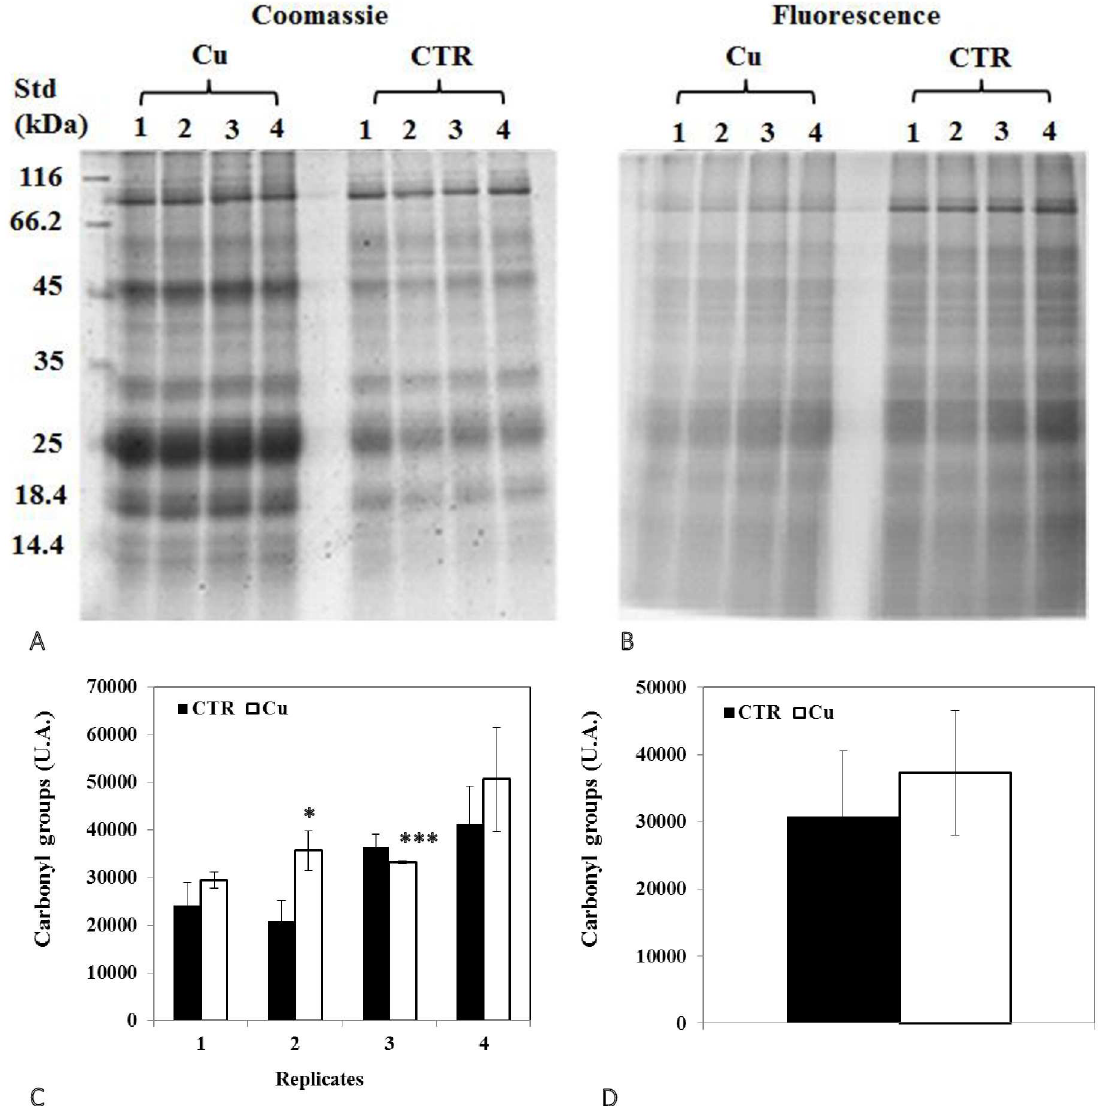
Fig 8. Representative images of 1DE gels of proteins (100 μ g) in cotyledons of bean seeds germinated for 3 days in the presenceof (A) distilled water (CTR) or (B) 200 μ M Cu. Gels were stainedwith Coomassie G-250 (scannedwith GS-800 calibrated densitometer) and with FTSC labeling(scannedwith Typhoon 9400scanner). Total optical densitiesfor each lane obtainedfrom FTSC staining were normalized with those from Coomassie G-250 staining of the same gel. (C, D) Levels of proteinscontainingcarbonylgroups. Valuesshown are (C) means of 4 biologicalreplicates( ± SD) numbered from 1 to 4, and (D) means of 4 technicalreplicates ( ± SD).Each measurement was performed in an extract obtainedfrom several cotyledons. Analyseswere performed using ANOVA, student’s T test; *** p < 0.001.